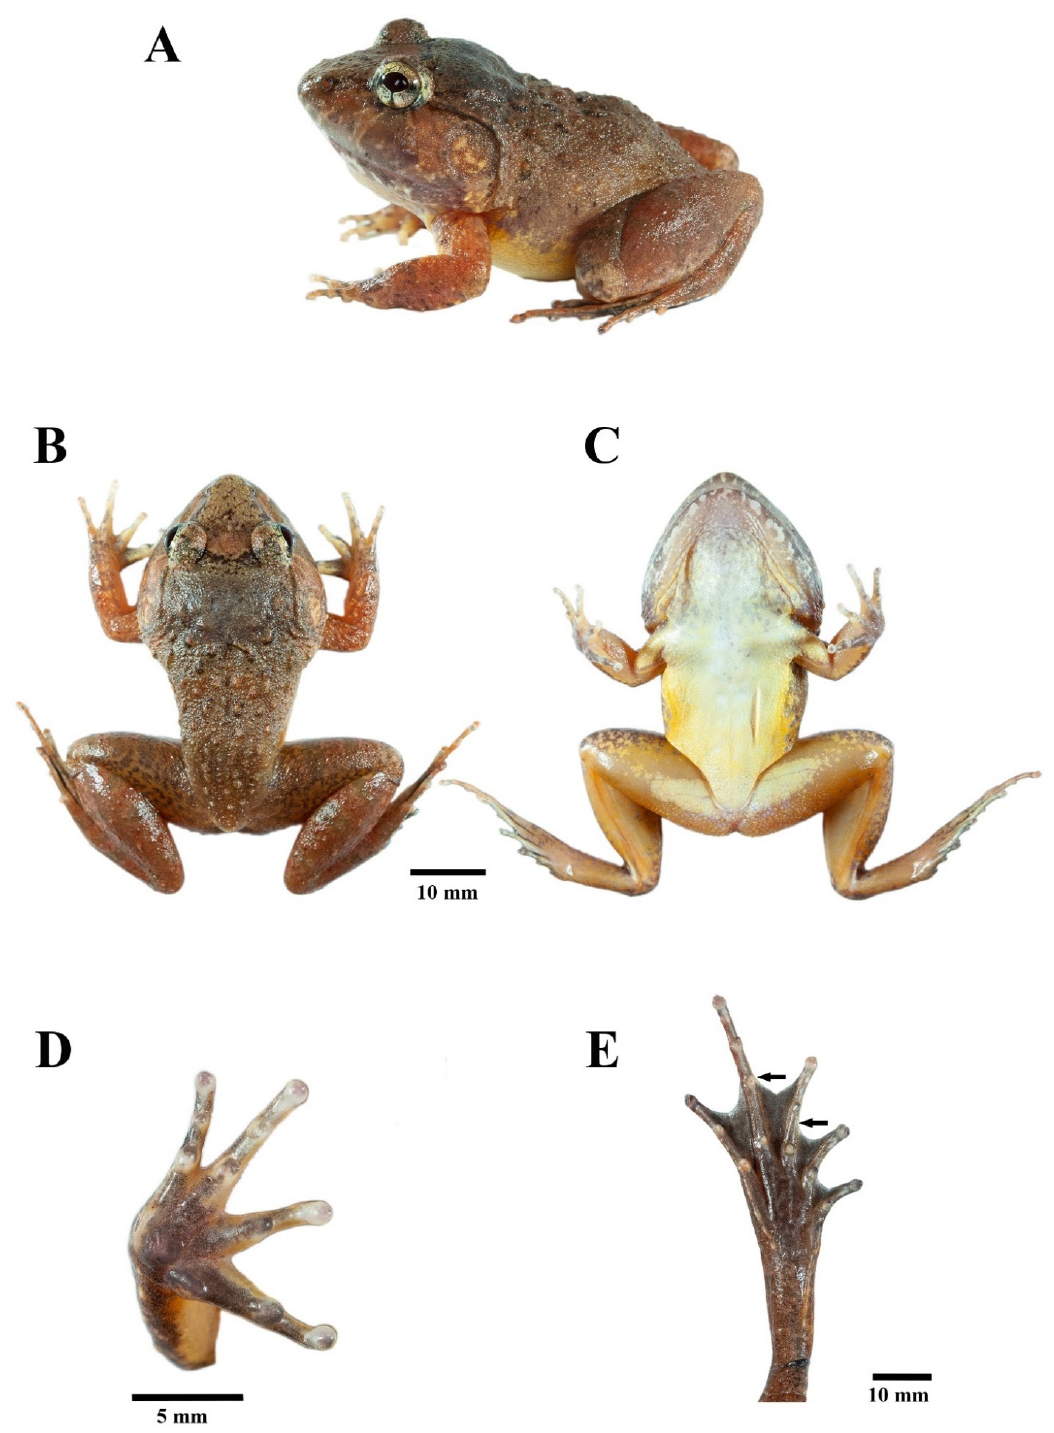
Figure 5. Holotype of Limnonectes pseudodoriae sp. nov . (ZMKU AM 01567) in life. ( A ) Lateral view, ( B ) dorsal view, ( C ) ventral view, ( D ) palmar view of the right hand, and ( E ) plantar view of the right foot. Arrows refer to diagnostic characters in toe webbing.